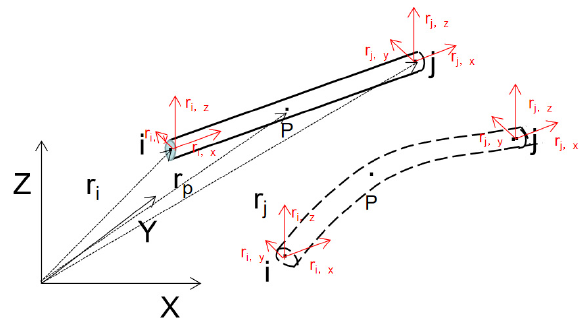
Figure 1. ANCF cable element model.